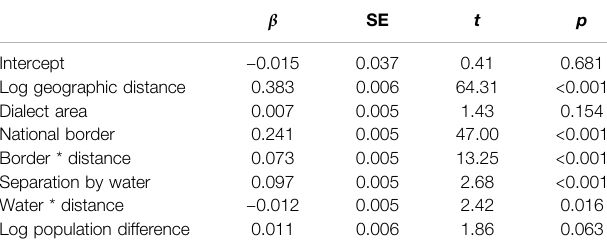
TABLE 14 | Linear mixed-effect modeling results for the Society and education domain, showing beta coef fi cients, standard errors, t-values and signi fi cance